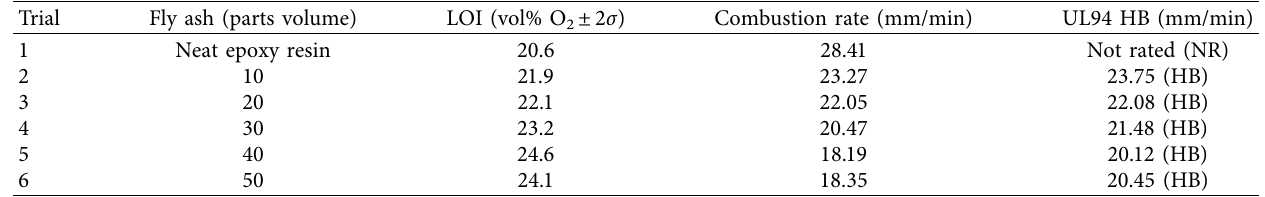
Table 3: Results for flammability tests (reaction to small flame) oxygen index (OI) and UL 94 for nanocomposites. Trial Fly ash (parts volume)